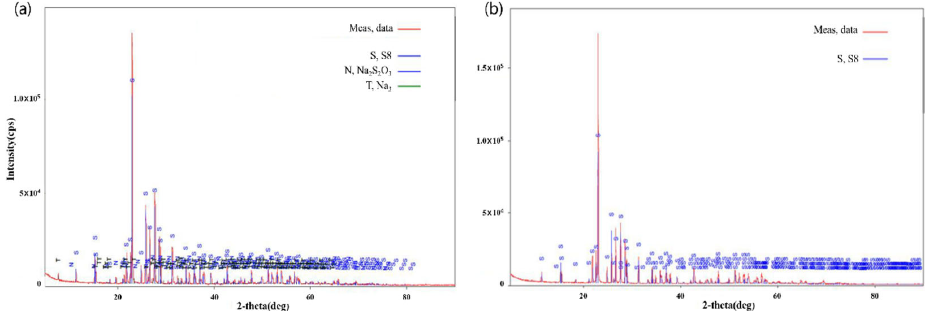
Figure 4. XRD results of the dry bio-sulfur ( a ) and petroleum sulfur ( b ). The sulfur format in ( a ) is S8, with Na also present, and the sulfur format in ( b ) is S 8 .